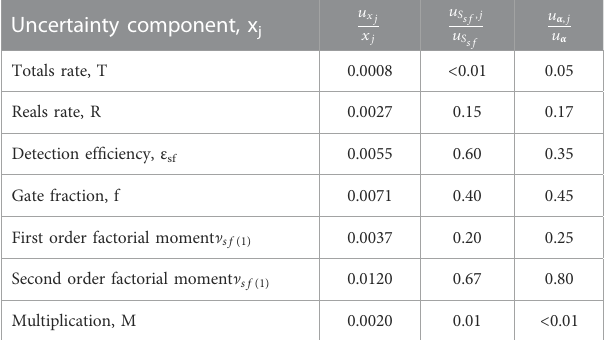
TABLE 15 Contribution of the counting statistics, the detection ef fi ciency, gate fraction, fi rst and second order factorial moments for 244 Cm(sf) and neutron multiplicationtotheuncertaintyofthederivedneutronproductionratedueto spontaneous fi ssion and the α -ratio. Uncertainty component, x